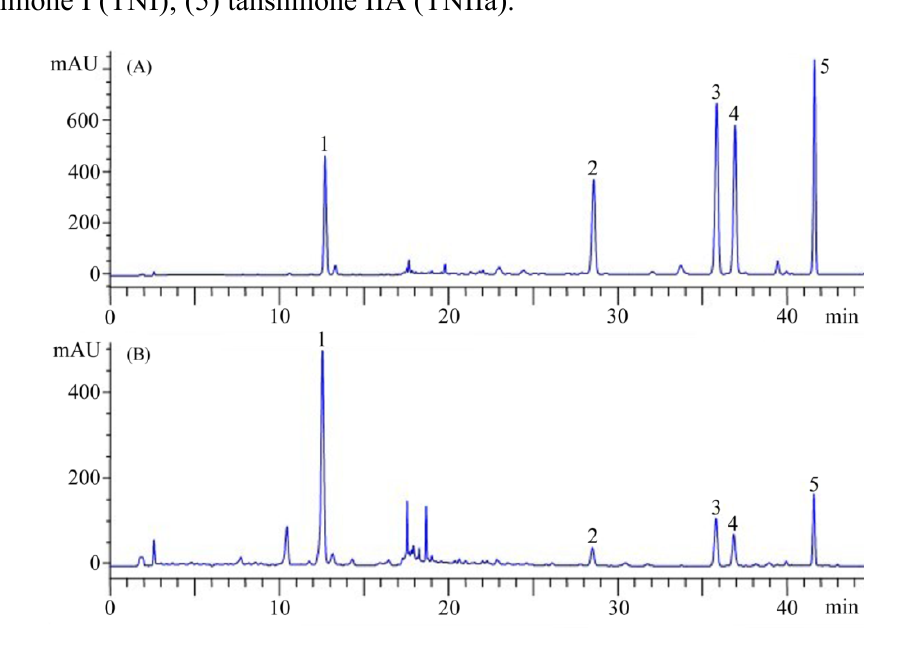
Figure 3. Typical chromatograms of standard mixture solution ( A ) and sample ( B